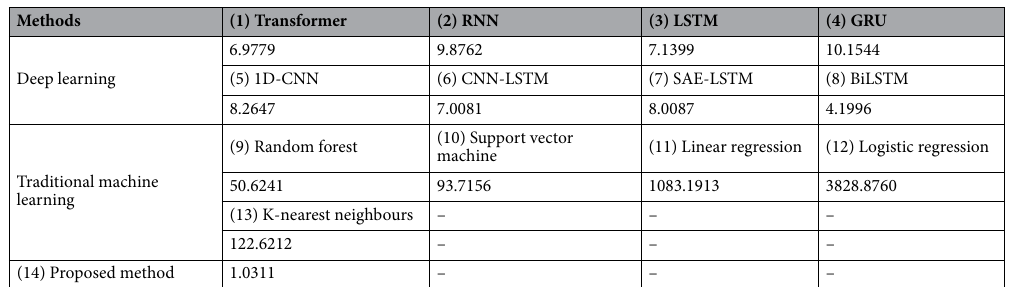
Table 3. RMSE results of different methods under the same data settings. (1) Transformer; (2) RNN; (3) LSTM; (4) GRU; (5) 1D-CNN; (6) CNN-LSTM; (7) SAE-LSTM; (8) BiLSTM; (9)RF; (10) SVM; (11) LR; (12) LOR; (13) KN; (14) proposed